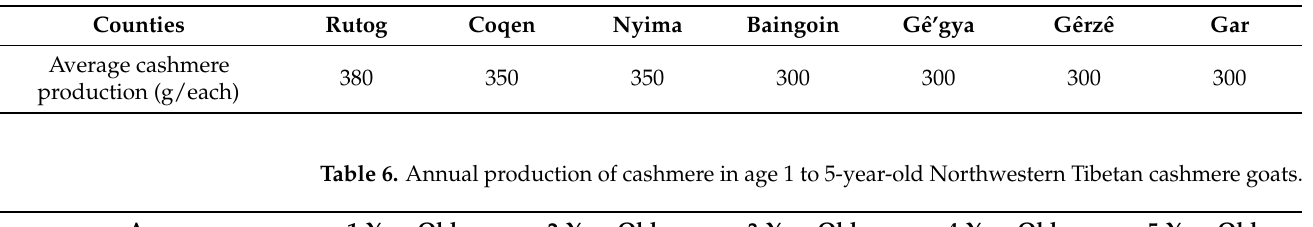
Table 5. Annual production of cashmere in each of the six districts with Northwestern Tibetan cashmere goats.